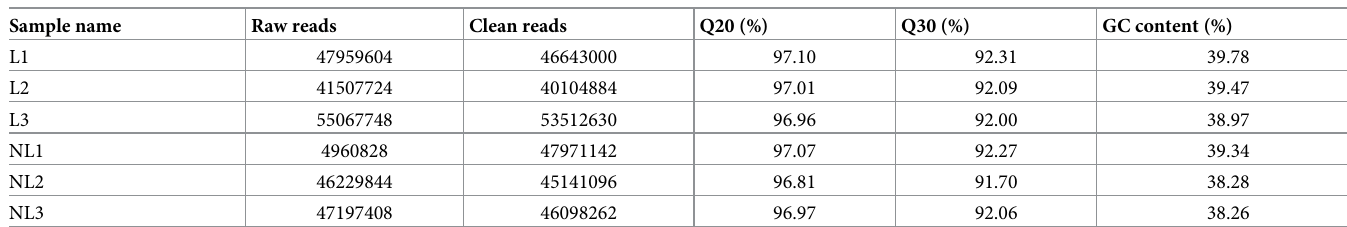
Table 1. Summary of data quality